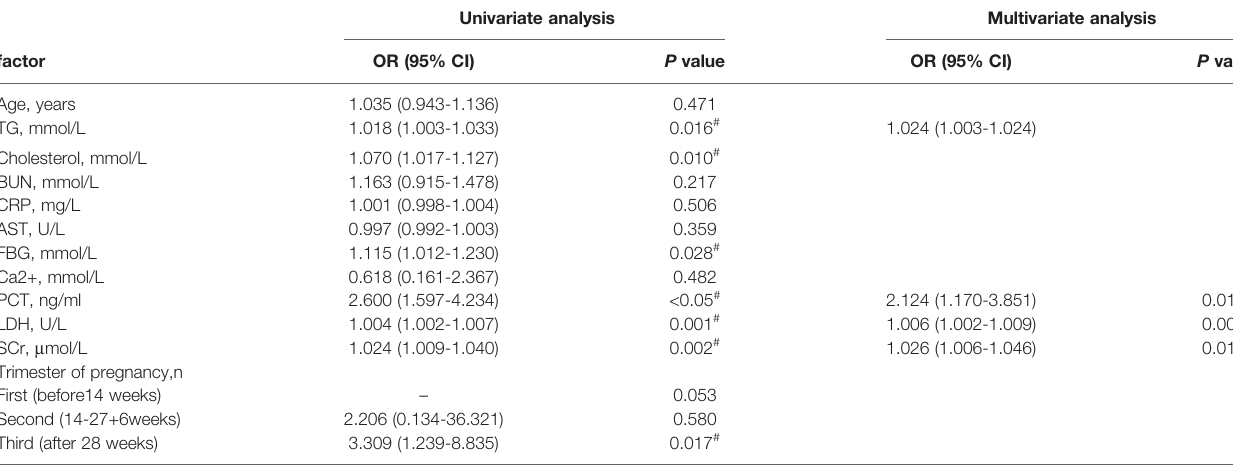
TABLE 5 | Univariate and multivariate logistic regression analysis of risk factors associated with POF.